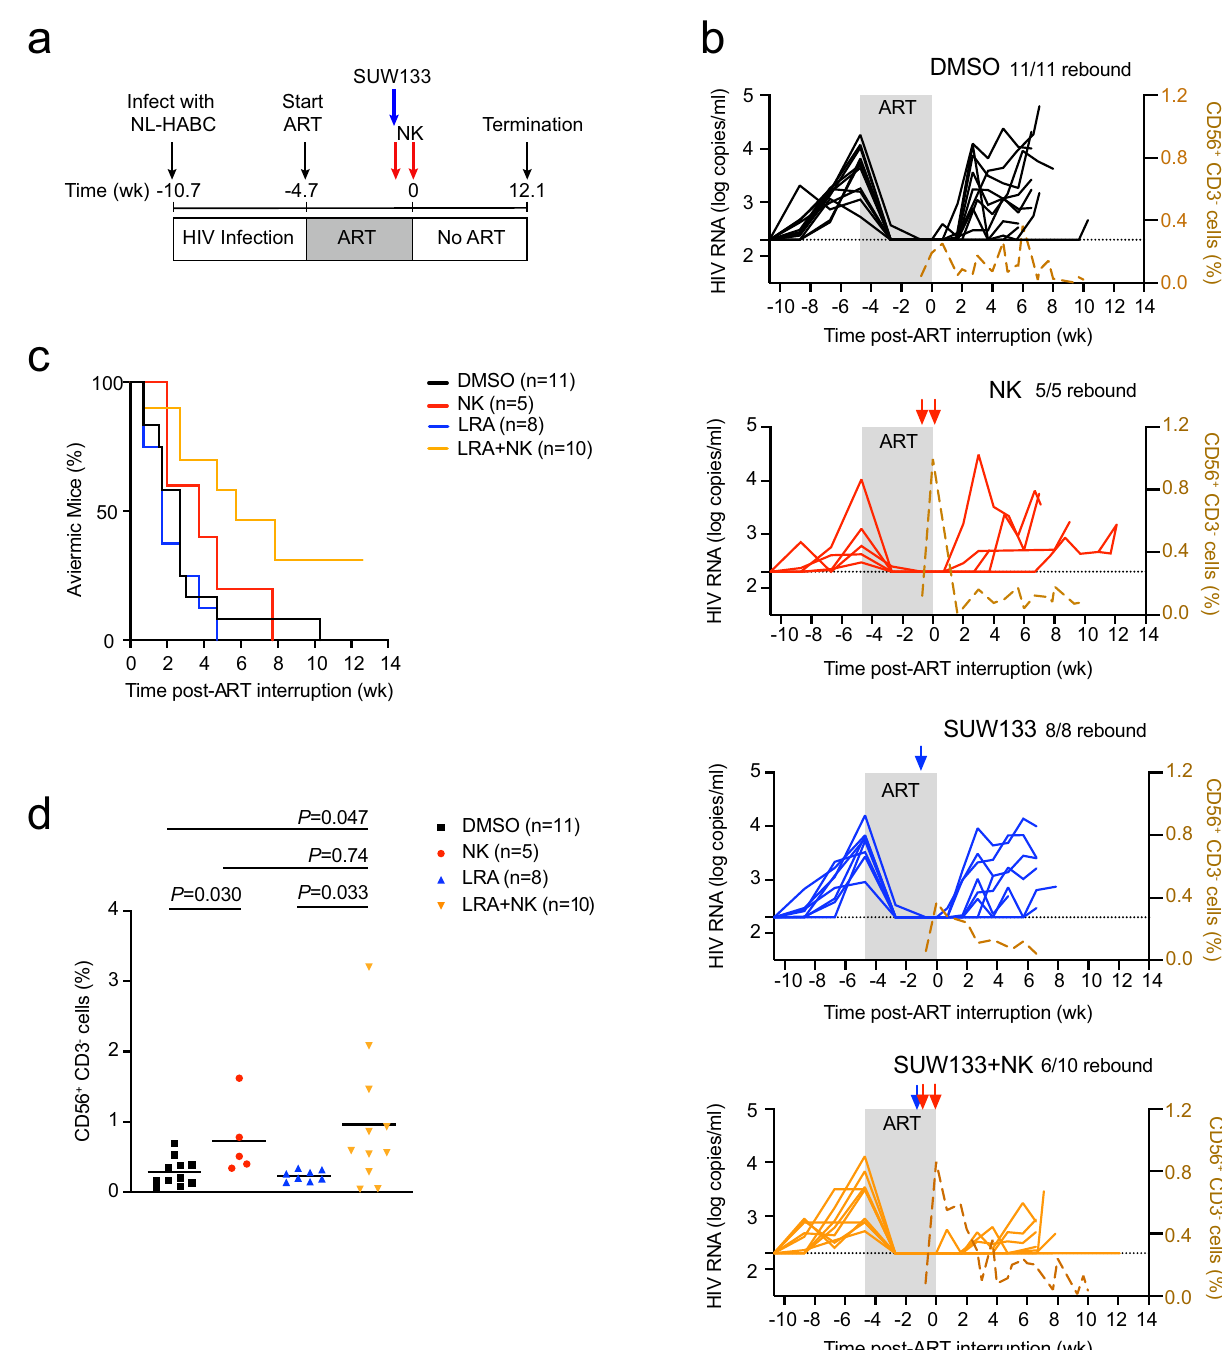
Fig. 5 SUW133 plus NK cells delay viral rebound after ART interruption. a Schematic representation of experiment; acute infection of TKO-BLT mice with NL-HABC. ART for 4.7 weeks. SUW133 (blue arrow) or control vehicle DMSO was administered 5 days prior to stopping ART. 5 × 10 6 allogeneic human peripheral blood NK cells (red arrows) were injected the same day as injection of SUW133 or DMSO and another homologous dose of cells were given 5 days later on the day of ART discontinuation. b Longitudinal plasma viral loads for each infected animal at various timepoints in the DMSO only (black), NK only (red), LRA only (blue), and LRA plus NK (orange) groups. Gray shading indicates an ART treatment period of 4.7 weeks. A dashed brown line indicates the median frequency of CD56 + CD3 − cells detected in the blood. The black dotted line indicates the detection limit of 2.3 log RNA copies per ml. c Kaplan – Meier curves showing the frequency of aviremic mice after ART interruption. d Frequency of CD56 + CD3 − cells in the blood 5 days after the fi rst injection of NK cells. Horizontal bars represent the means. P values were calculated using the two-tailed Mann – Whitney test. n = 11 biologically independent animals in DMSO group, n = 5 biologically independent animals in NK group, n = 8 biologically independent animals in the LRA group, n = 10 biologically independent animals in LRA plus NK group ( b – d ). Results are pooled from two independent experiments. Source data are provided as a Source Data fi